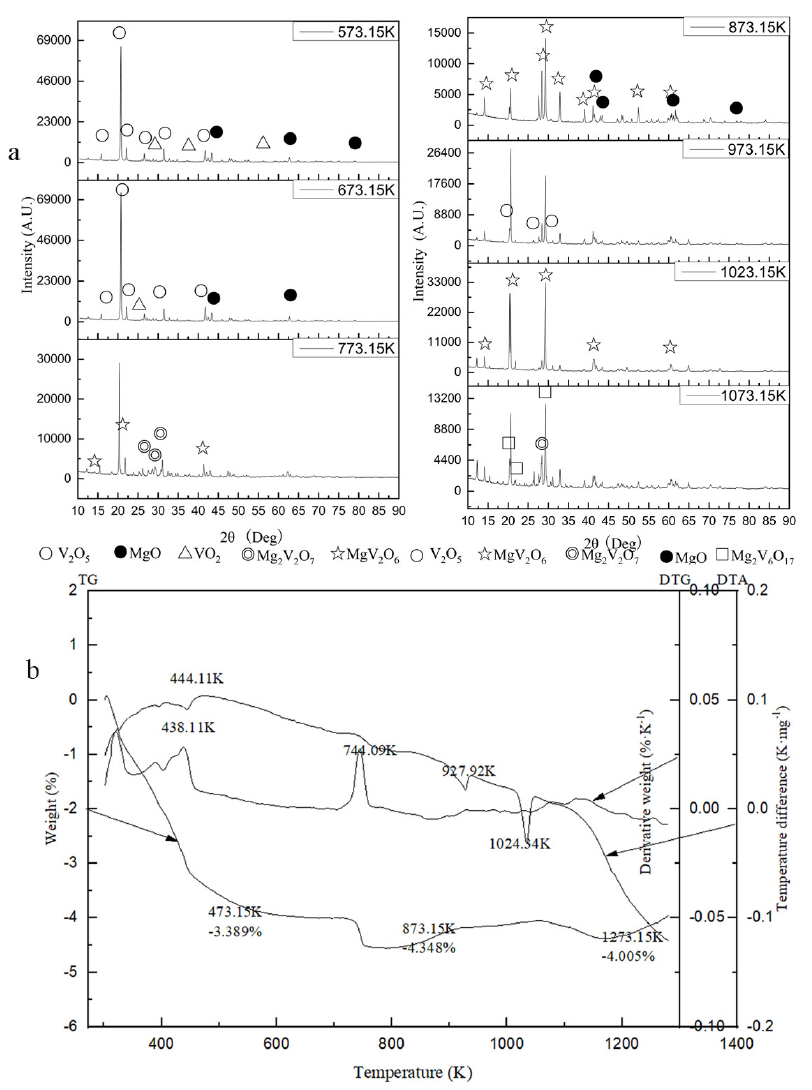
Figure 4. (a)The XDR pattern and (b) TG-DTG-DTA curve of sample roasted at different temperatures for 1 hour with the molar ratio of V